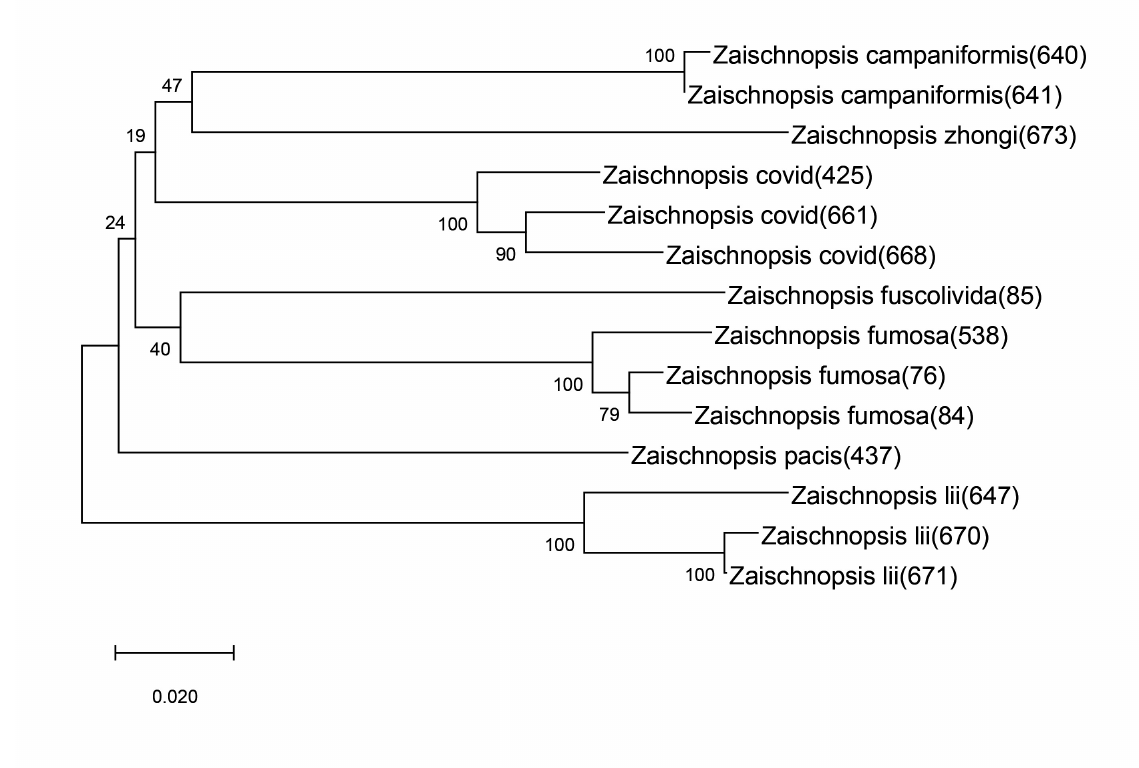
Fig. 11. The NJ tree (Neighbor-Joining) on COI sequences of the new species and Z . fumosa Peng & Xiang,